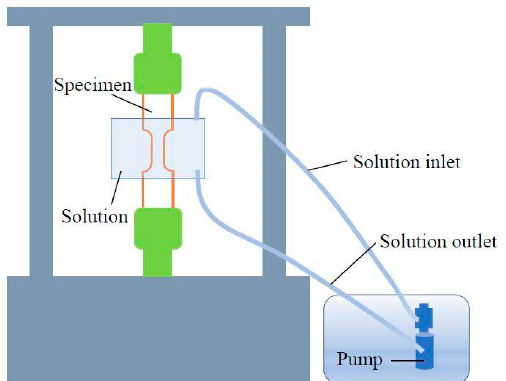
Figure 1. Schematic of the experimental set-up of the slow strain rate technique (SSRT) test.